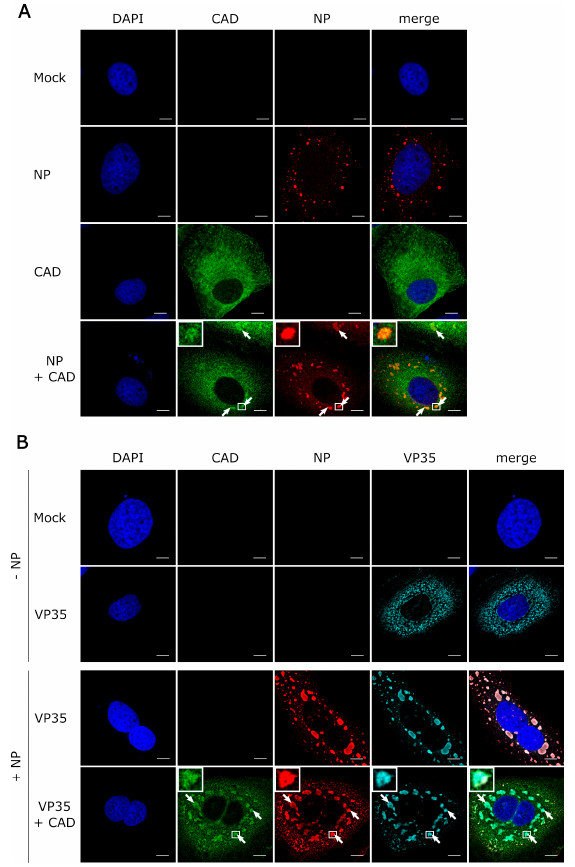
1 Figure 4. Recruitment of CAD into NP-induced inclusion bodies. ( A ) Colocalization between CAD and NP-induced inclusion bodies. Huh7 cells were transfected with plasmids encoding FLAG / HA-CAD and EBOV-NP as indicated. 48 h post-transfection, the cells were fixed with 4% paraformaldehyde and permeabilized with 0.1% Triton X-100. FLAG-tagged CAD (shown in green) was detected using an anti-FLAG antibody and NP (shown in red) was stained with anti-EBOV NP antibodies. ( B ) Recruitment of CAD into inclusion bodies occurs in the presence of VP35. Huh7 cells were transfected with plasmids encoding FLAG / HA-CAD, EBOV-NP, and myc-EBOV-VP35 as indicated. 48 h post-transfection, the cells were fixed with 4% PFA and permeabilized with 0.1% Triton X-100. FLAG-tagged CAD (shown in green) was detected using an anti-FLAG antibody, NP (shown in red) was stained with anti-EBOV NP antibodies, and myc-tagged VP35 (shown in turquoise) with an anti-myc antibody. The nuclei were stained with DAPI (shown in blue), and the cells were visualized by confocal laser scanning microscopy. The scale bars indicate 10 µ m. The arrows point out colocalization, and the insets show magnifications of the indicated areas. Merge shows an overlay of all three